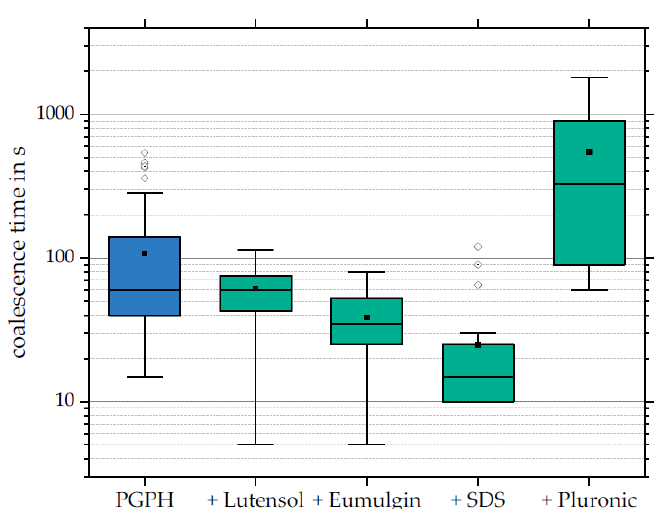
Figure 6. Coalescence time of water droplets stabilized by 0.1 wt% PGPH with additionally 0.001